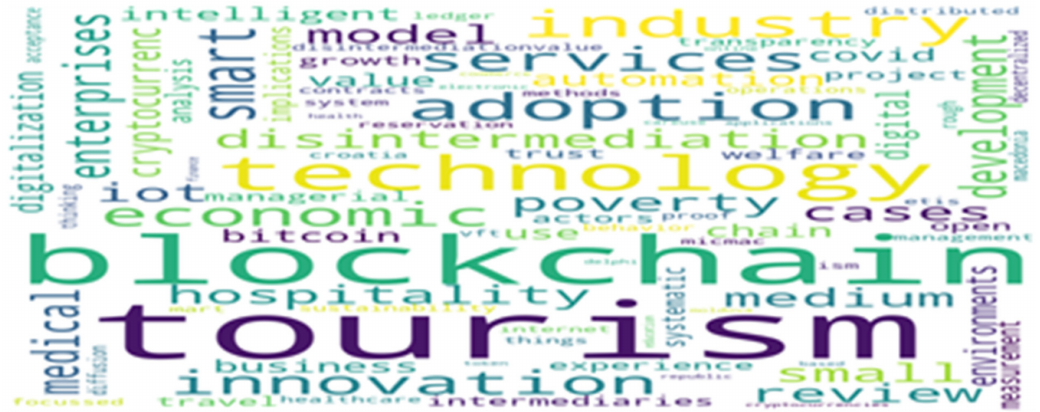
Figure 5. Word cloud for keywords. Source: Authors’ analysis.